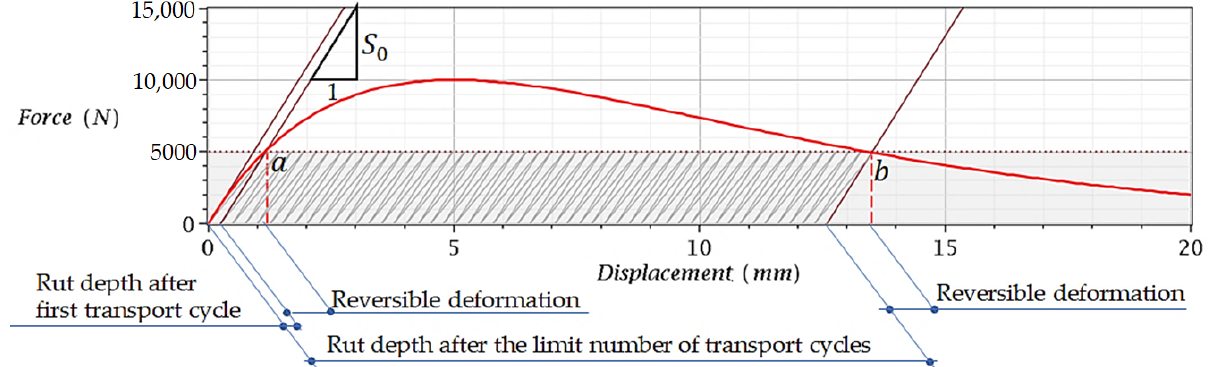
Figure 8. A schematic example of the influence of the number of transport cycles on the rut depth. One transport cycle corresponds to one passing of the vehicle (Figure 2). The stiffness of S 0 is determined by the ratio (10). Points a and b on the curve (red line) determine the rut depth depending on the load and the number of transport cycles.